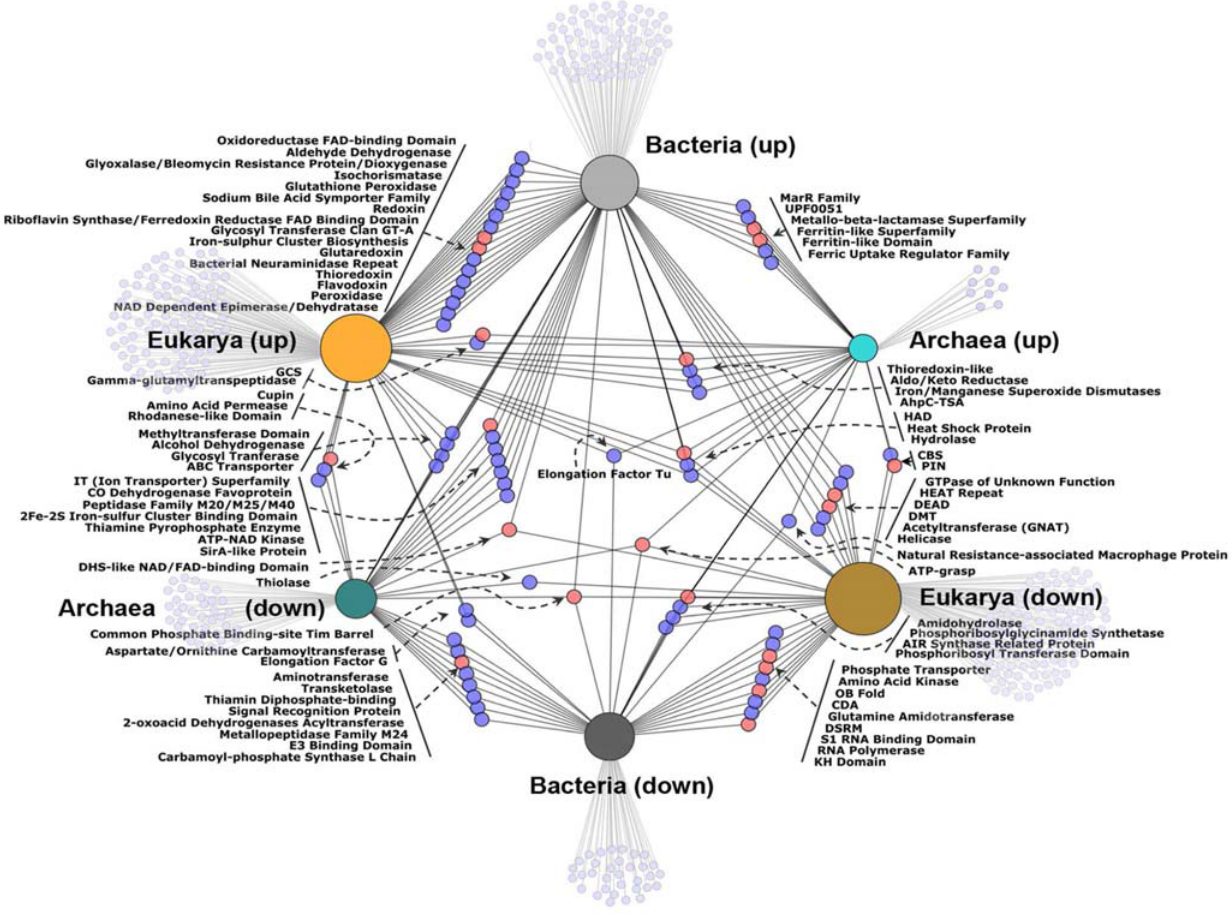
Figure 8. Network of shared mechanisms for oxidative stress response between Archaea, Bacteria, and Eukaryotes. Data from transcriptomics and proteomics experiments on S. solfataricus , Bacillus , E. coli, and Yeast after H 2 O 2 exposure were combined to assess the relatedness of representative organisms across the three domains of life. Blue nodes represent protein families and salmon nodes represent protein clans. Smaller gray nodes show pfams unique to a particular domain and direction of regulation. The size of the node for each domain is scaled to according to number of regulated pfams.